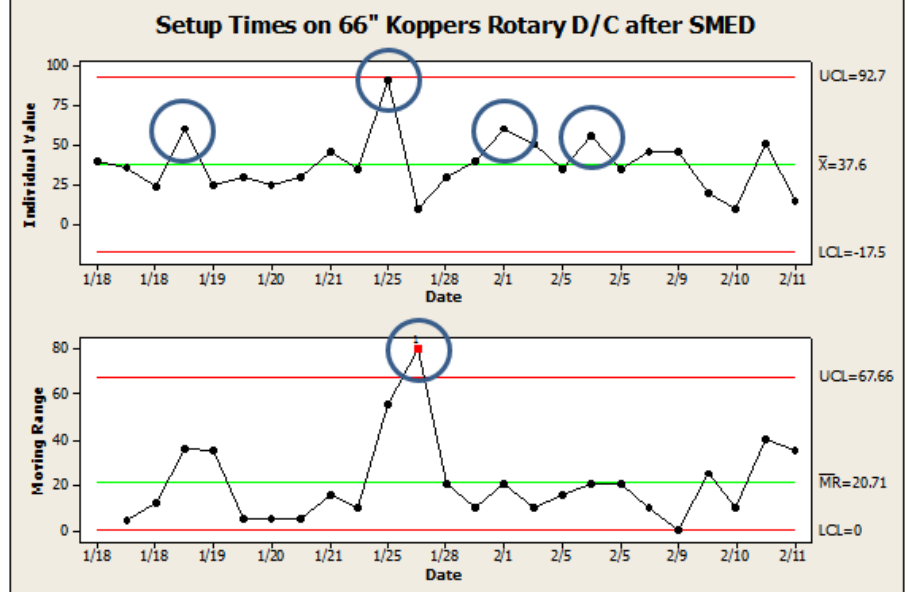
Fig. 2. Setup times during the last 25 setups after